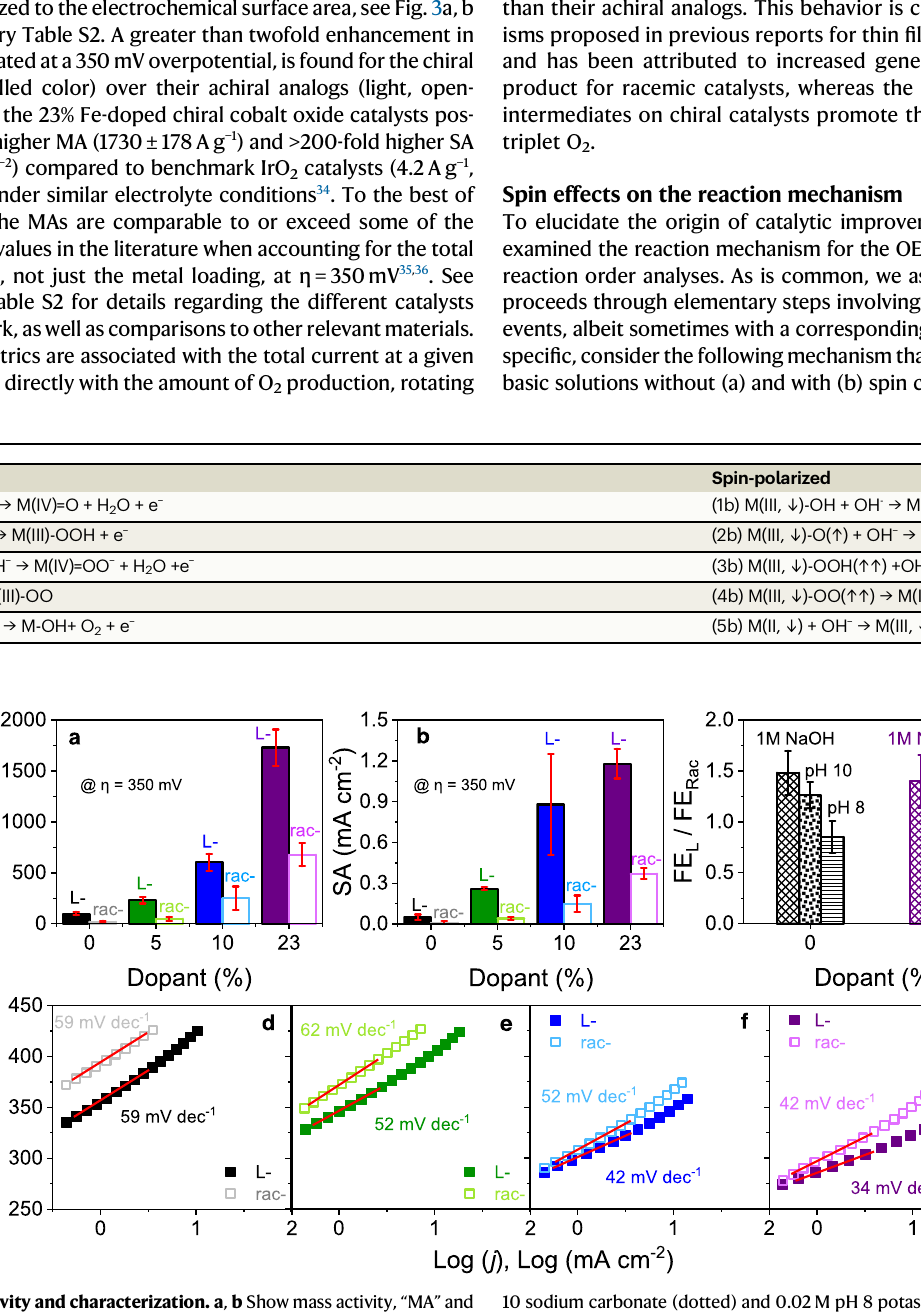
10 sodium carbonate (dotted) and 0.02M pH 8 potassium phosphate (cross-hat- ched) buffer solutions. The error bars represent the standard deviation across at least three independent electrode preparations. d – g Show Tafel plots and corre- sponding slopes for undoped and 5, 10, and 23% iron-doped Rac- (open symbol) and L-cobalt oxide ( fi lled symbol) nanoparticles,